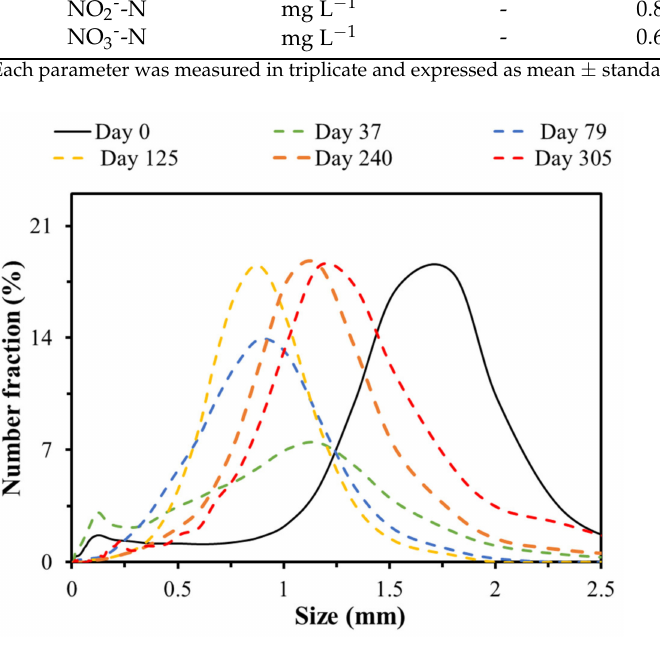
Figure 3. Particle size distribution in the GMBR in the course of 305 days of